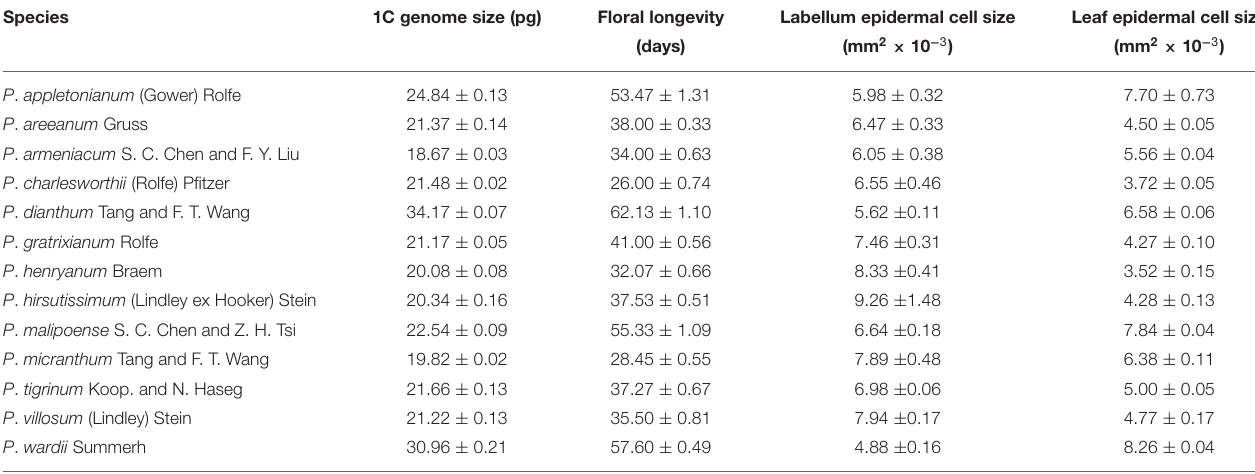
TABLE 1 | Mean values of genome size from leaf tissue ( n = 3), floral longevity (10–20 flowers from different plants), epidermal cell size of labellum ( n = 6), and leaf ( n = 6) from 13 Paphiopedilum species.